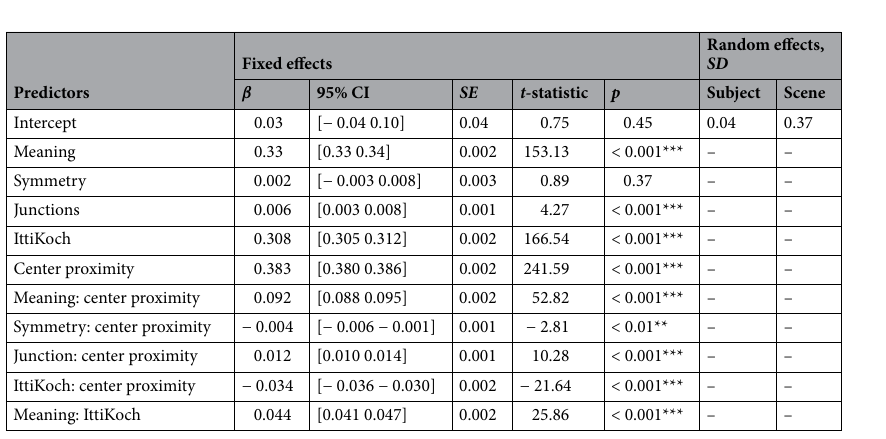
Table 2. MSI-Net LME Results. Beta estimates ( β ), 95% confidence intervals (CI), standard errors (SE), t -statistic, and p values ( p ) for each fixed effect and standard deviations ( SD ) for the random effects of subject and scene.